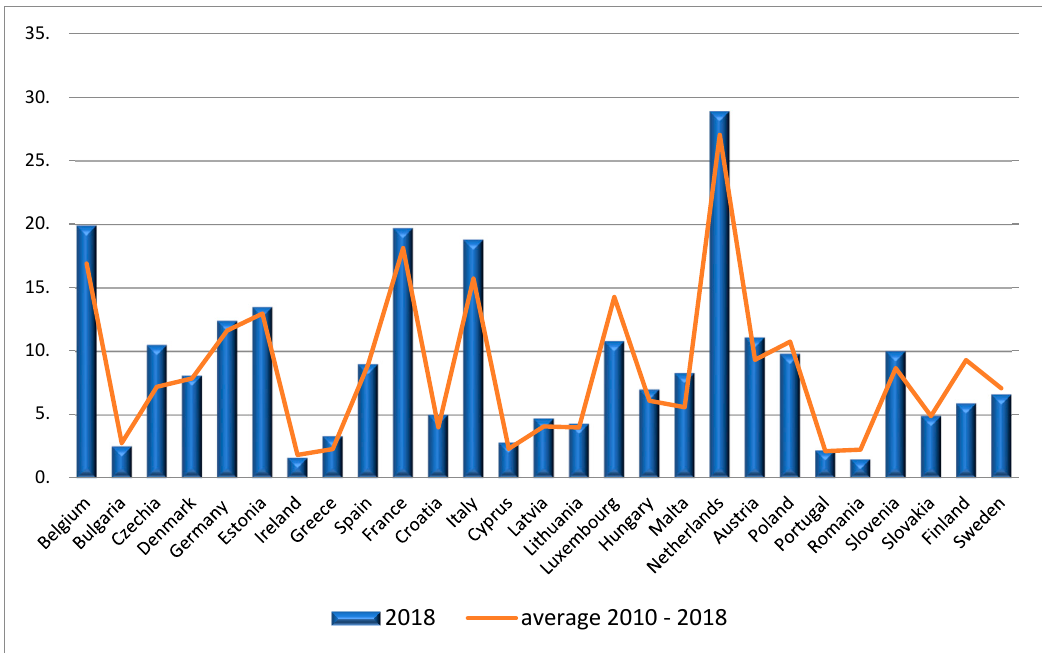
Figure 7. Circular material use rate.